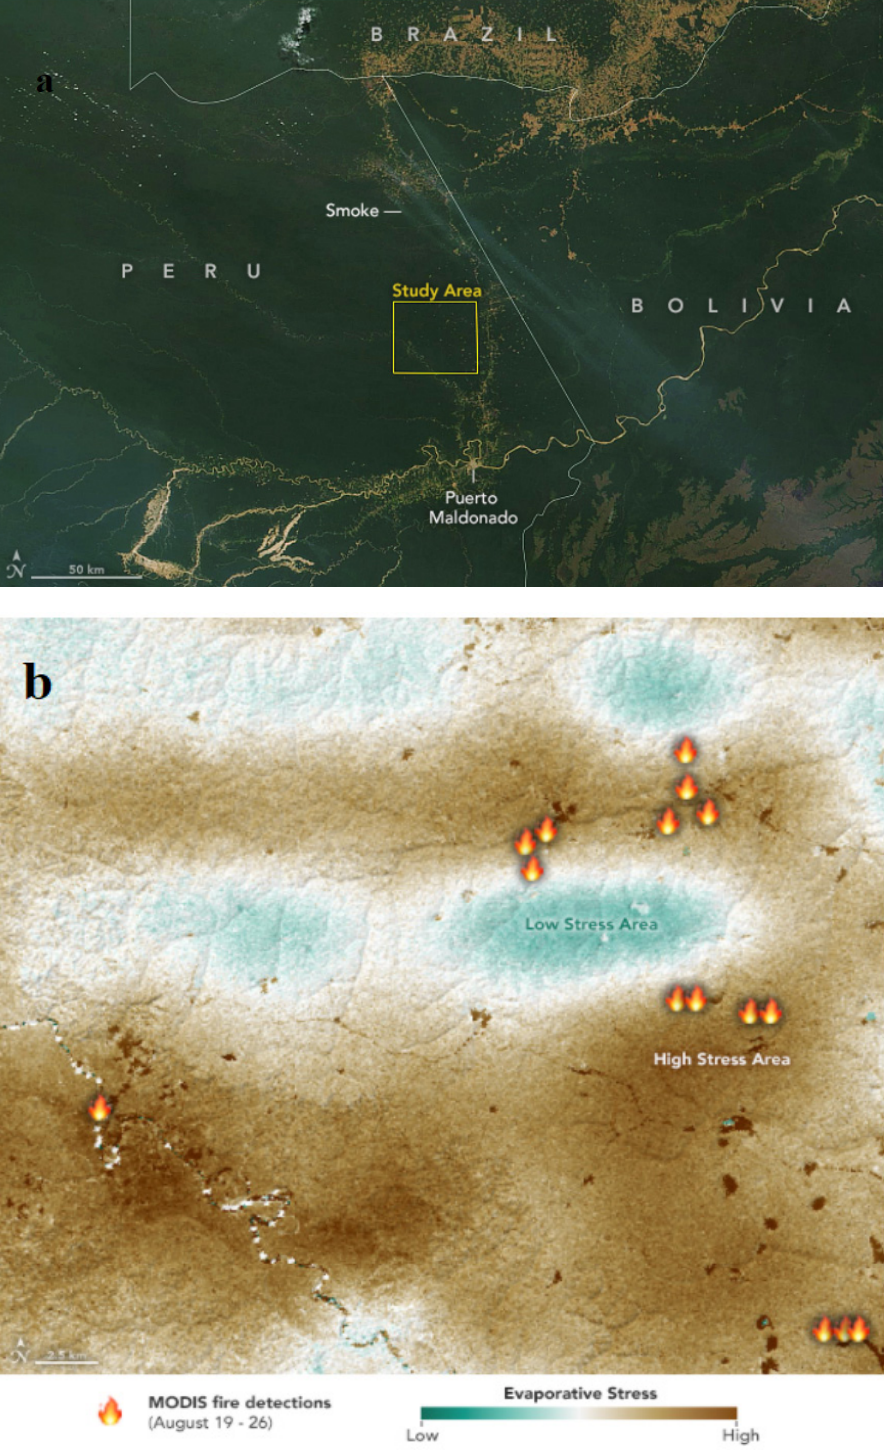
Figure 4. Evapotranspiration stress by Terra satellite of NASA’s MODIS system and Ecostress system in east Peru. ( a ) Study area of the conducted tests, and ( b ) crop water stress from high to mid and low [74].